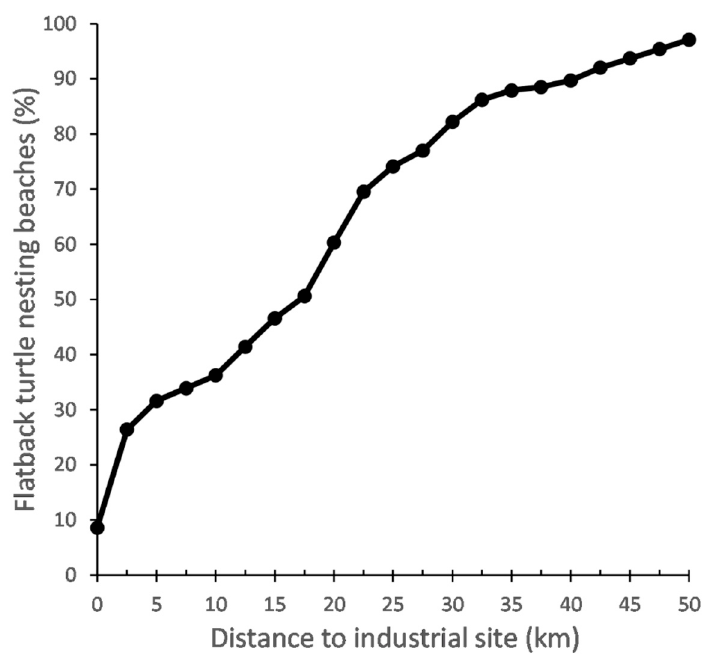
Figure 5. Percentage of flatback turtle nesting beaches in the Pilbara region of Western Australia located within an increasing radius of an industrial site. At 50 km, 97.1% of beaches (n = 169) are encompassed.